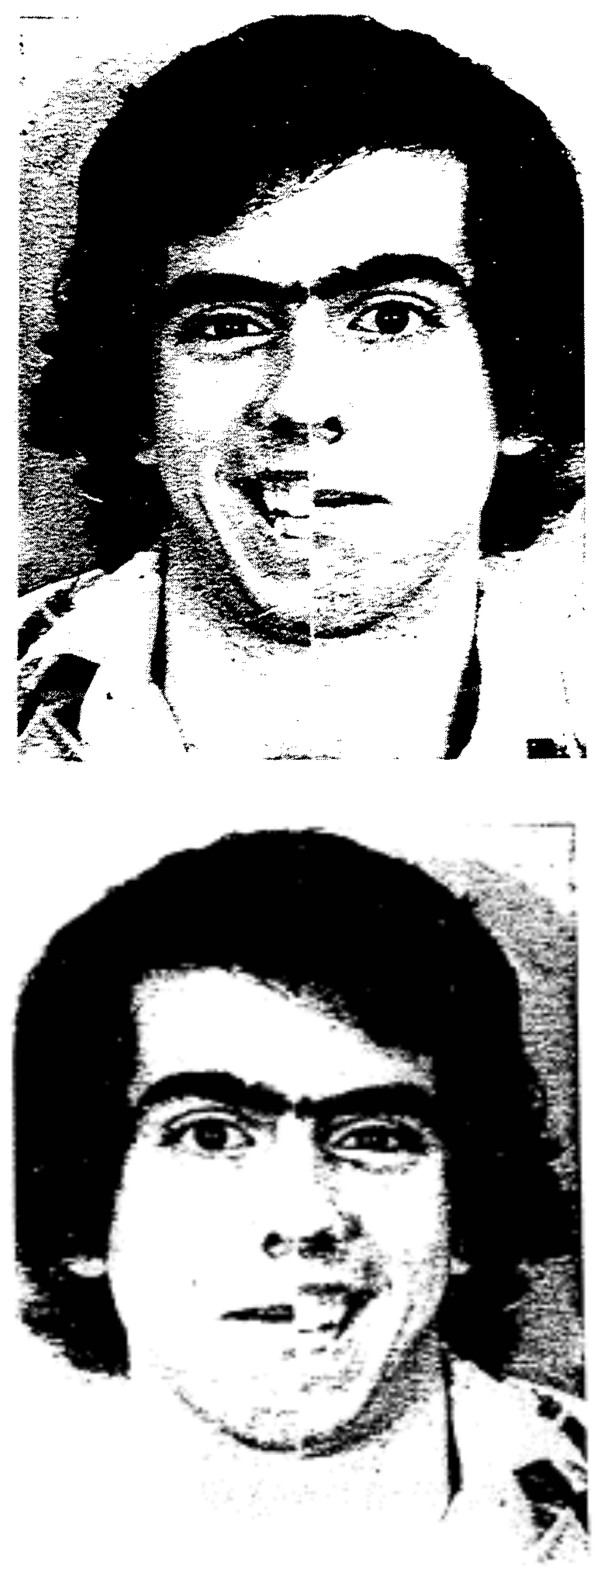
Chimeric Faces Test (CFT). A sample page from the CFT (see Methods), which was used to measure hemispheric utilization bias.